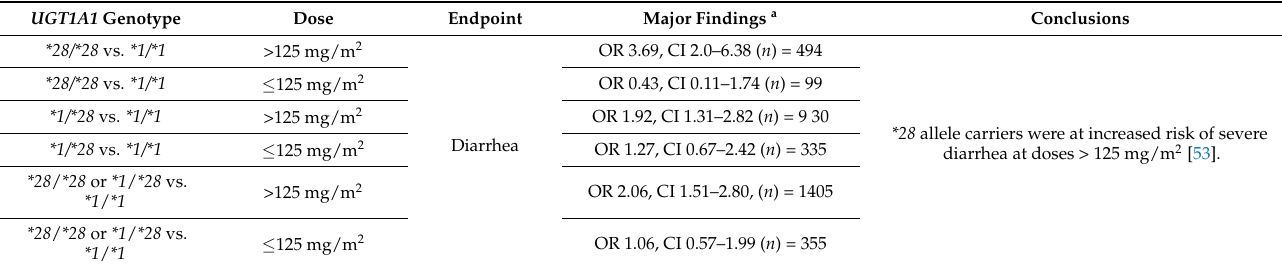
Table 2. Meta-analyses investigating the pharmacogenetic influence of UGT1A1 with the use of irinotecan. UGT1A1 Genotype Dose Endpoint Major Findings